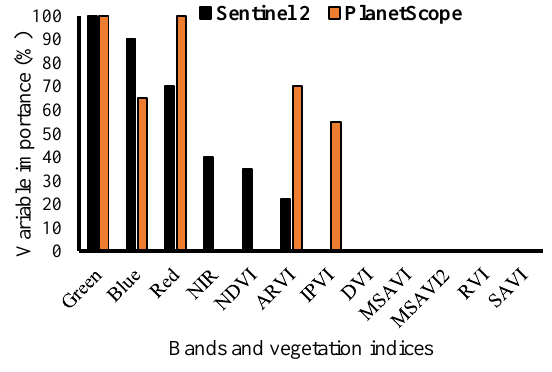
Figure 2: Variable importance percentage for both Sentinel-2 and PlanetScope derived metrics using the GRRF variable selection measure